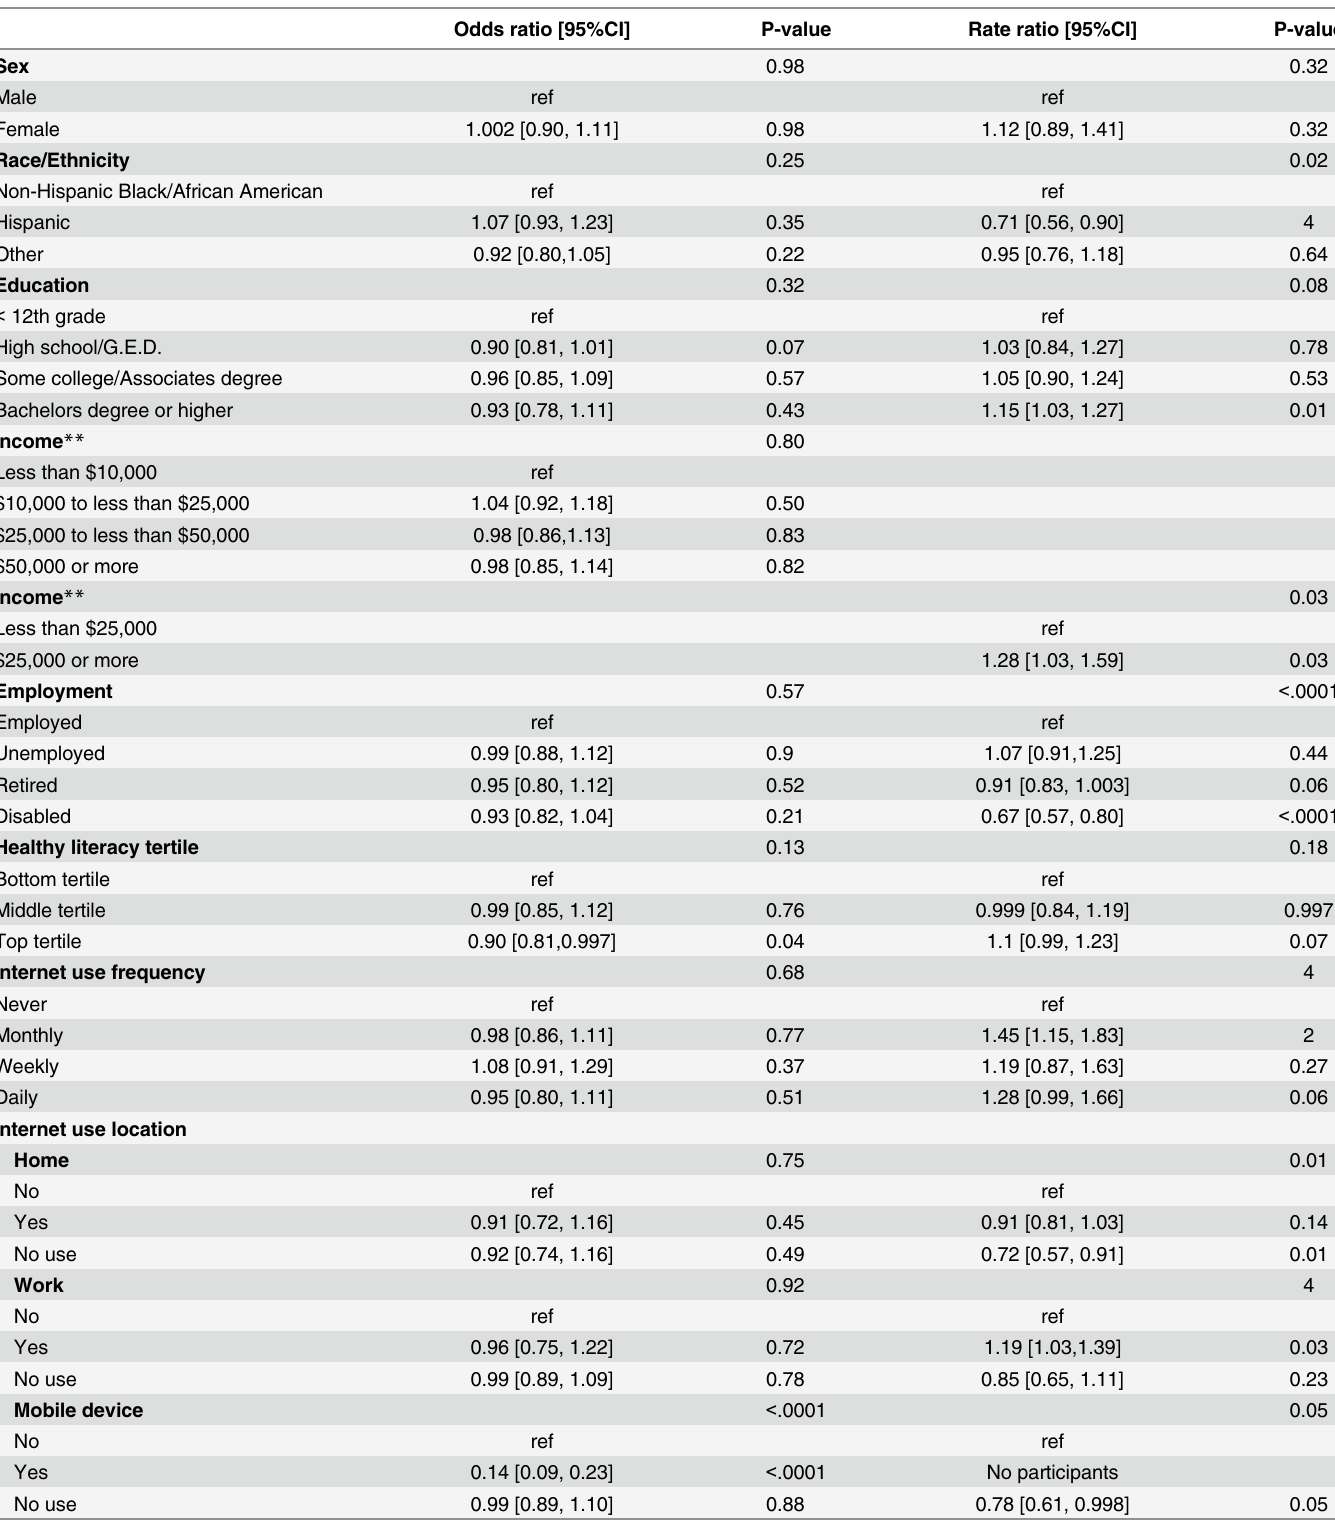
Table 3. Association between patient characteristics and change in self-monitoring rate by self-monitoring modality over a 13 week